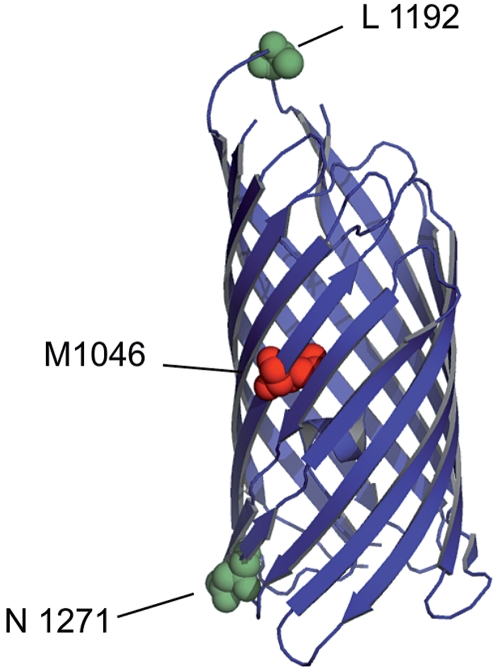
Transport activity of linker inserts in the β-domain.Three linker mutants locate inserts in the β-barrel of EspP as indicated by coloured spheres. Inserts within loop regions were permissive to transport (illustrated green), while insertion in the central part of the barrel lead to loss of transport activity (indicated red).